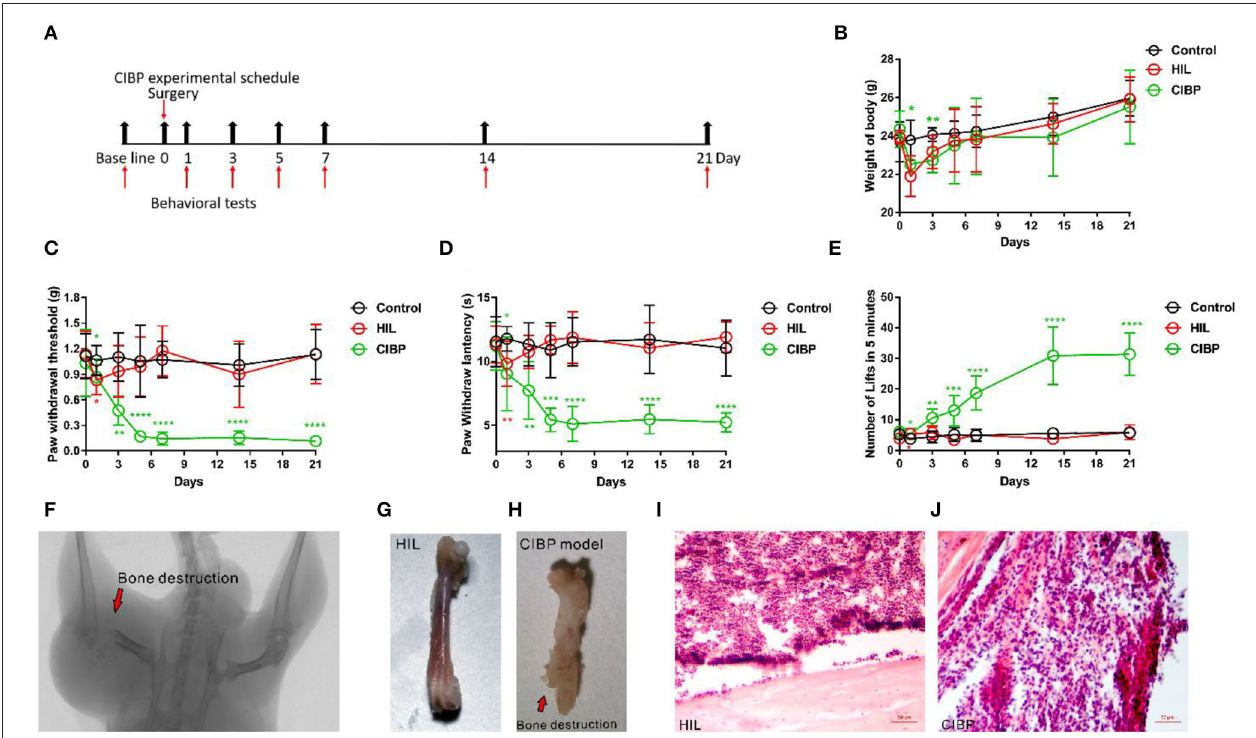
FIGURE 1 | The mechanical, heat, and cold allodynia enhanced after injecting Lewis lung cancer cells. (A) Experimental schedule of the CIBP model. (B) The weights were recorded after CIBP operation, n = 6 mice/group. (C) The mechanical allodynia was tested after CIBP surgery, n = 9 mice/group. (D) The heat allodynia was recorded after CIBP operation, n = 9 mice/group. (E) The cold allodynia was recorded after CIBP operation, n = 9 mice/group. (F) Radiograph results represent robust radiolucent lesions (arrowhead) of the femur on the 21st day. (G,H) The femur is intact in the control group while the bone shows fractures and holes swallowed by Lewis lung cancer cells in the CIBP group on the 21st day. (I,J) Histopathological sections (hematoxylin and eosin stain) show that the bone marrow was largely replaced by invading tumor cells with medullary bone loss and femur destruction on the 21st day. Scale bar: 50 µ m. * p < 0.05, ** p < 0.01, *** p < 0.001, **** P < 0.0 001 (*in red font is compared between HIL and control group, *in green font is compared between CIBP and HIL group), two-way (B–E) repeated measures ANOVA followed by post-hoc